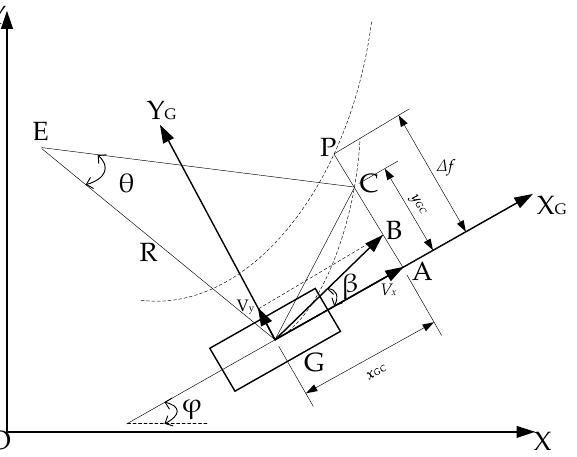
Figure 2. Steady ‐ state transverse pendulum angle single ‐ point preview model. Figure 2. Steady-state transverse pendulum angle single-point preview